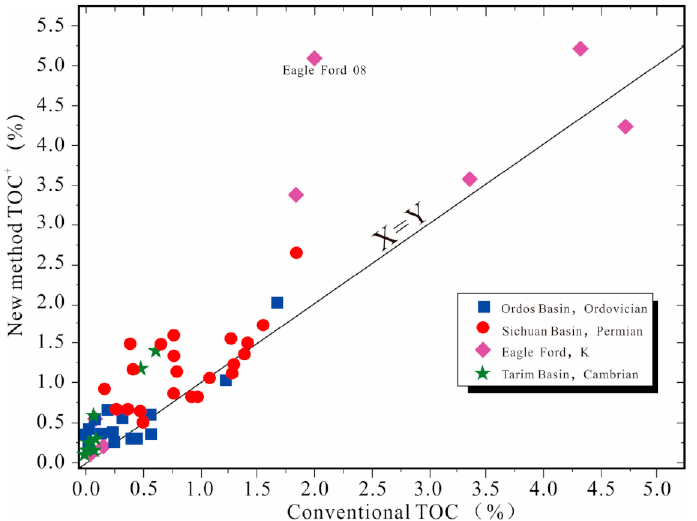
Figure 2. Comparison of the TOC values of carbonate source rocks from different regions measured using different